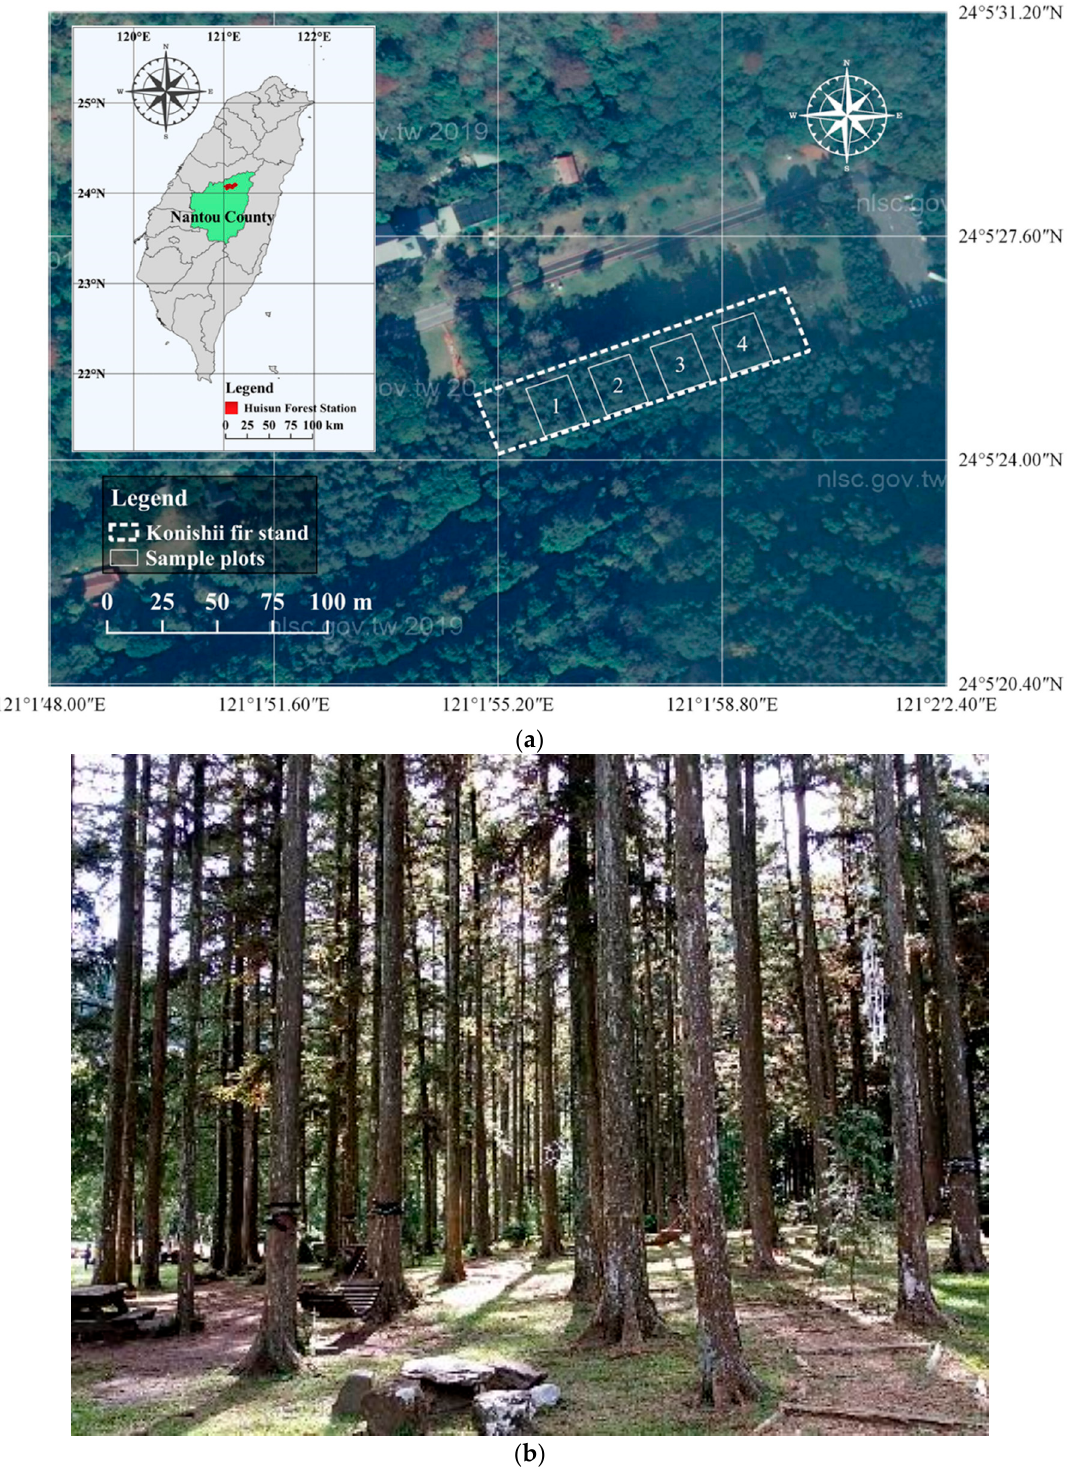
Figure 1. The study area and stand status ( a ) study site and plots (National Land Survey and Mapping Center, NLSC [38], ( b ) stand status of the Konishii fir at the survey period (2020/06/30 photo by Tian-Min Yen).